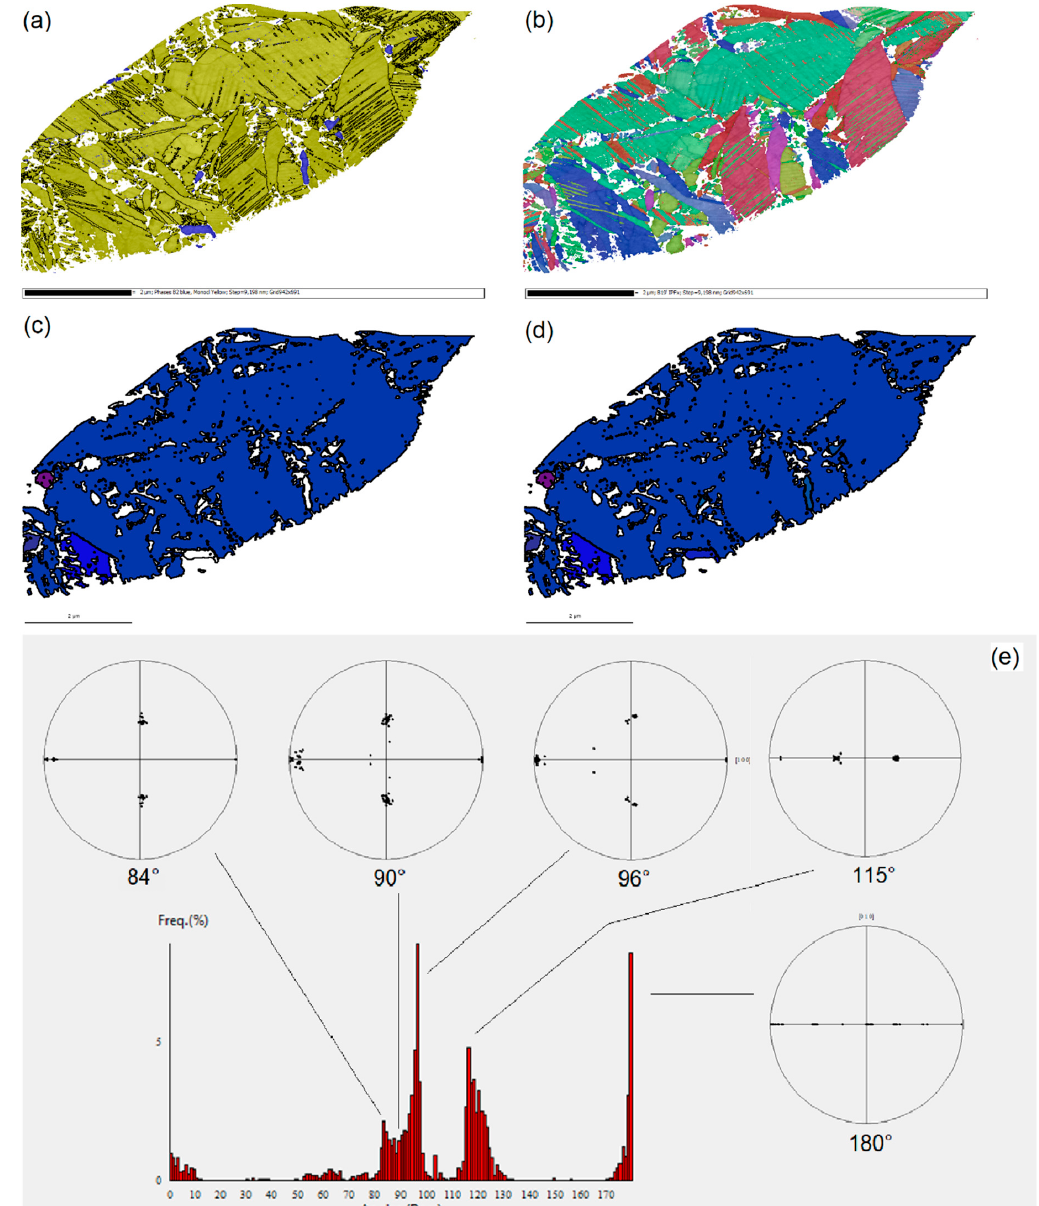
Figure 13. Transmission Kikuchi Diffraction (TKD) map 1. ( a ) Phase map with the B19 ′ martensite in yellow and the B2 phase in blue; ( b ) orientations of the B19 ′ martensite in IPFx colors; ( c ) B2 parent grains reconstructed by ARPGE from the B19 ′ martensite; ( d ) same map and “reversed” B2 grains in IPFz colors; ( e ) histogram of disorientations between the B19 ′ martensite in each of the reconstructed parent B2 grains, with the rotation axes plotted in pole figure according to the convention of Figure 6. The scale bar in the maps is 2 μ m.